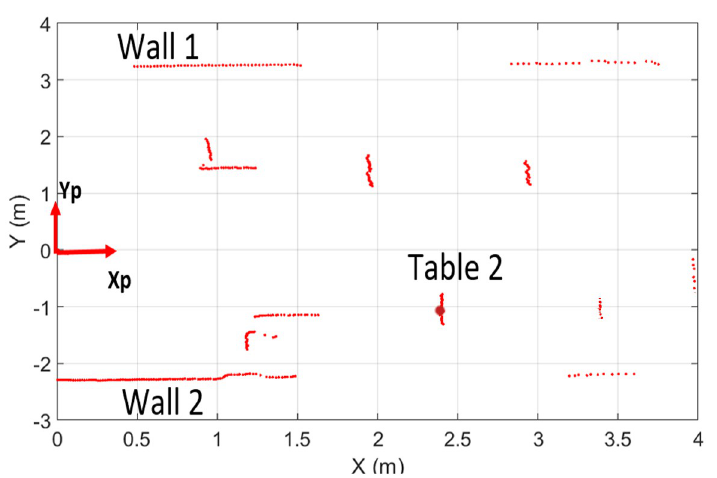
Fig 5. Laser scans of indoor environment of